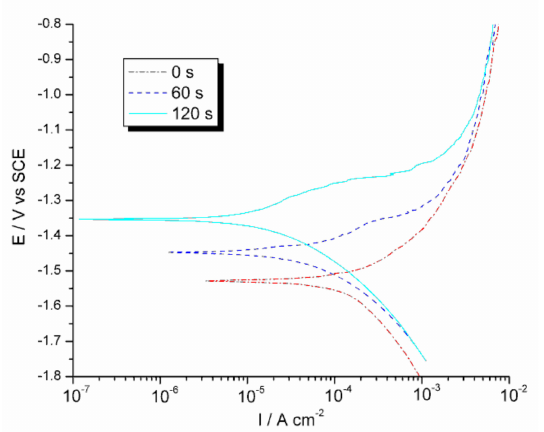
Figure 9. Linear sweep voltammetry on the Mg sample not subjected to any treatment (reference sample), the samples SMATed for 60 s and 120 s in 0.15 mol dm − 3 NaCl solution saturated with Mg(OH) 2 at the potential sweep rate of 1 mV s − 1